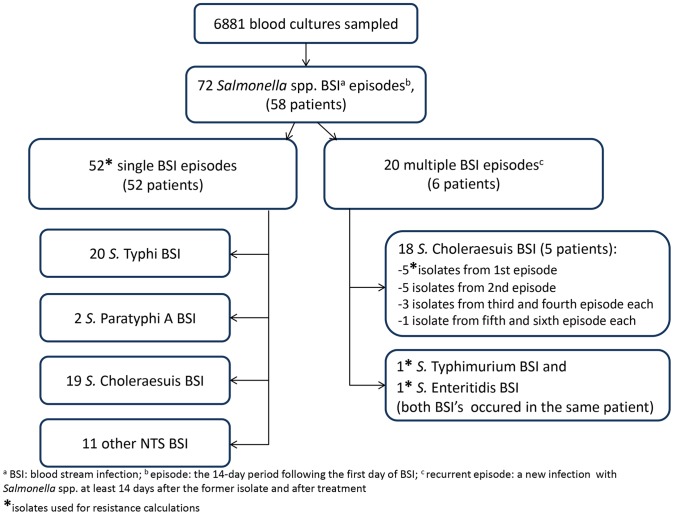
Flow chart of blood stream infection (BSI) episodes, patients and corresponding serovars.